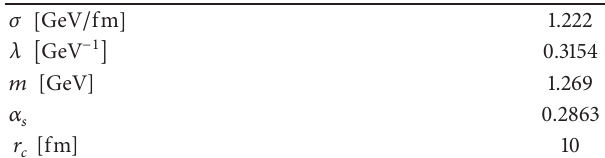
Table 1: Parameters of the